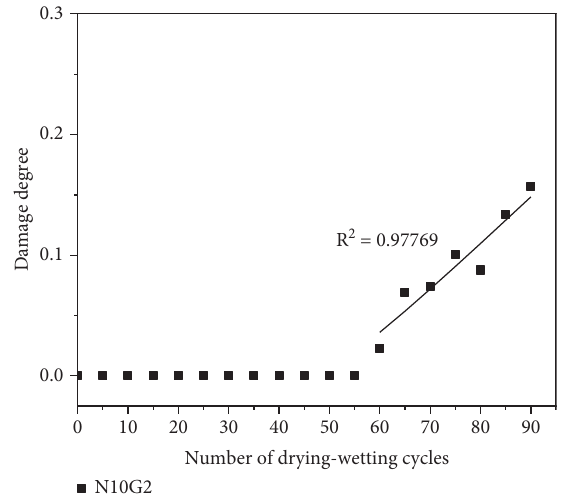
Figure 12: Variation of the damage degree for concrete under different drying-wetting cycle